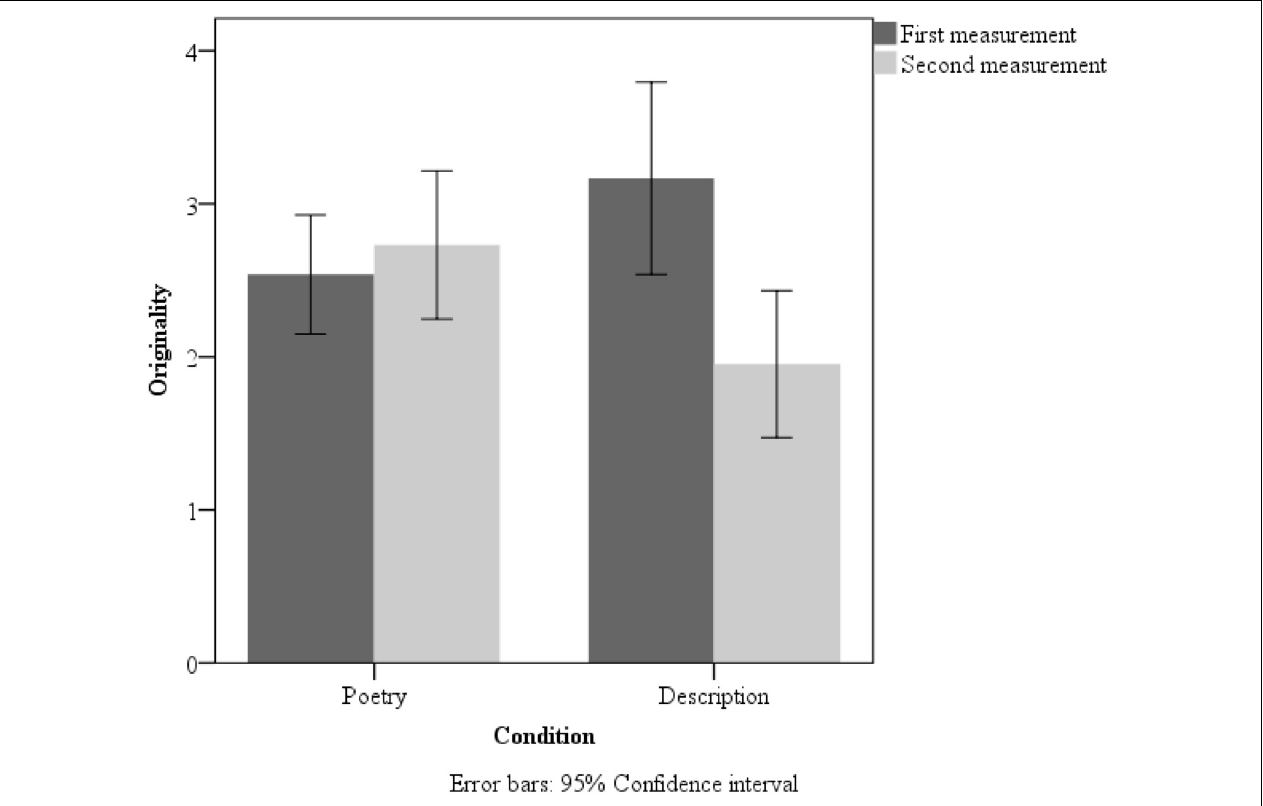
FIGURE 3 | Mean originality scores in the poetry-reading group and description-reading group in the first and second measurement in Study 1. Error bars: 95% Confidence